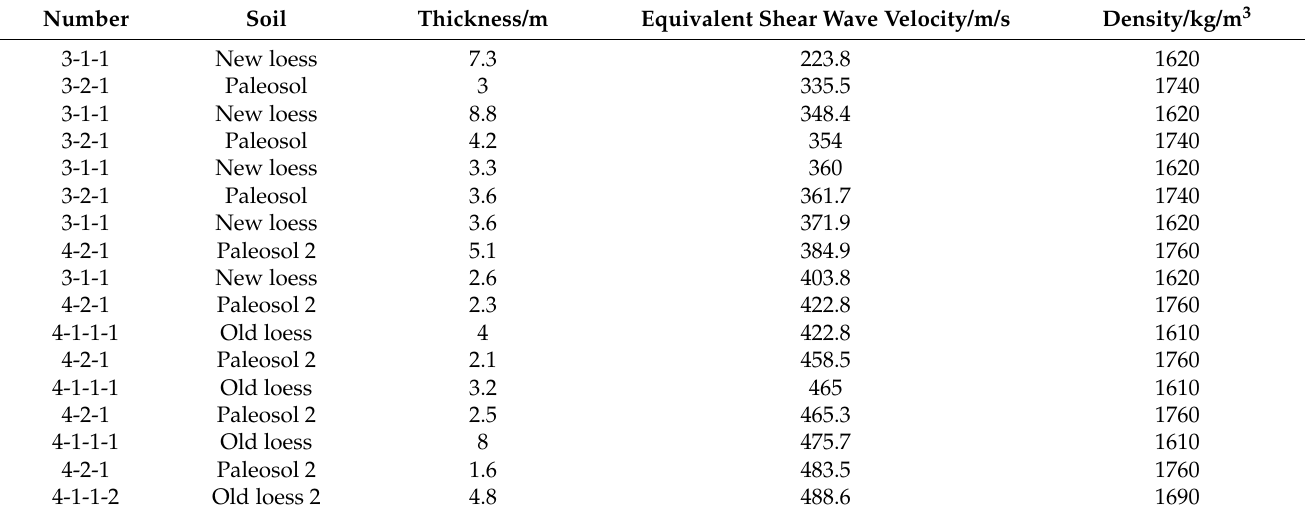
Table A2. Soil properties with increasing